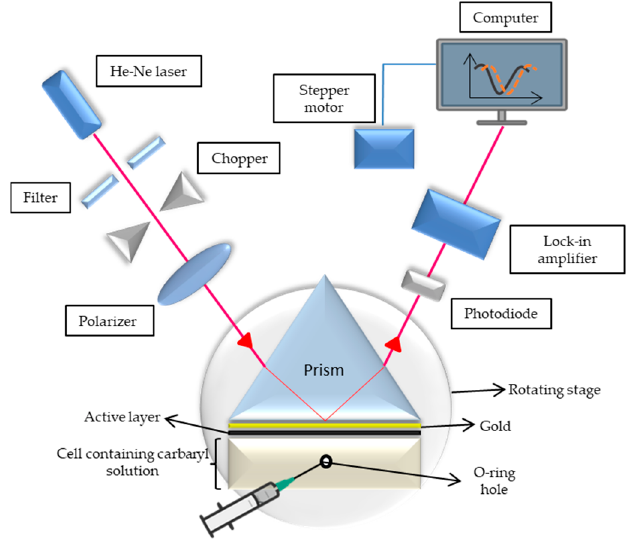
Figure 3. Schematic of surface plasmon resonance